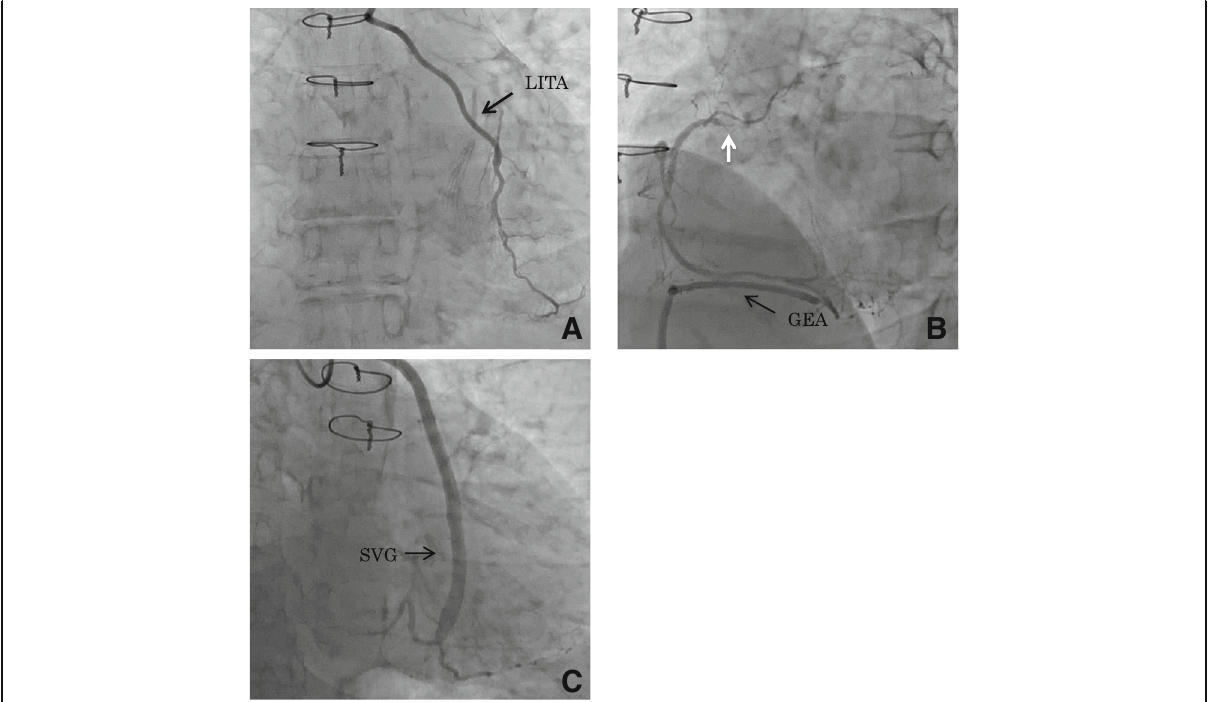
Fig. 1 Preoperative coronary angiogram. a The in situ LITA to the occluded LAD. b The in situ GEA to the occluded GEA. The arrow indicates the occlusion of the orifice of the right coronary artery. c The saphenous graft between the ascending aorta and the posterolateral branch of the left circumflex